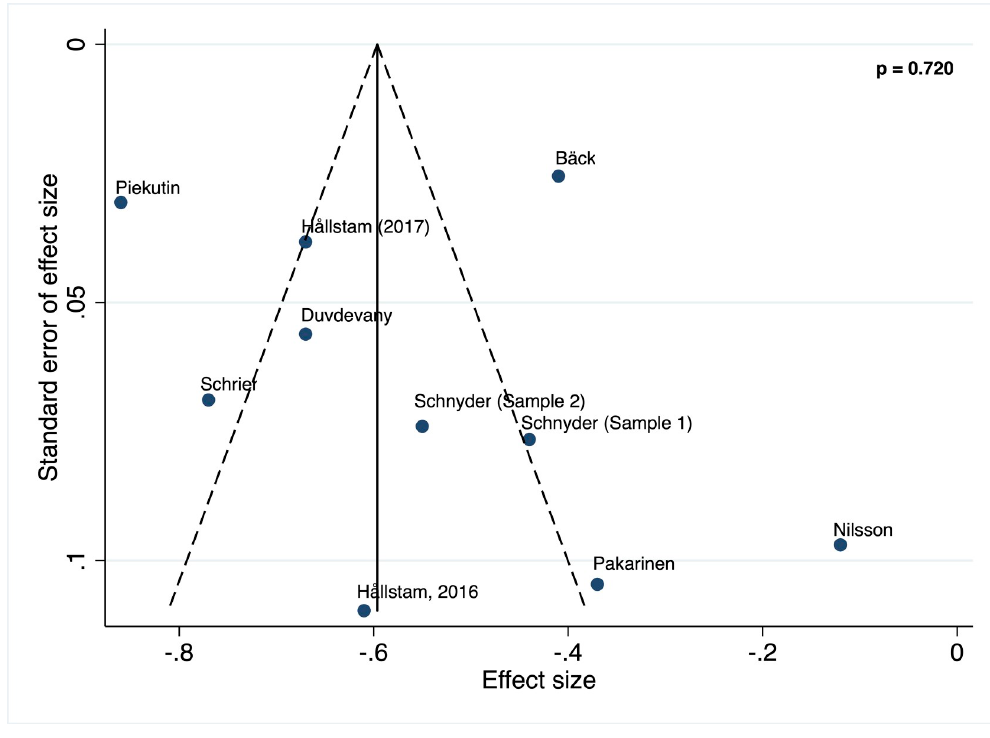
Fig 5. Egger test for publication